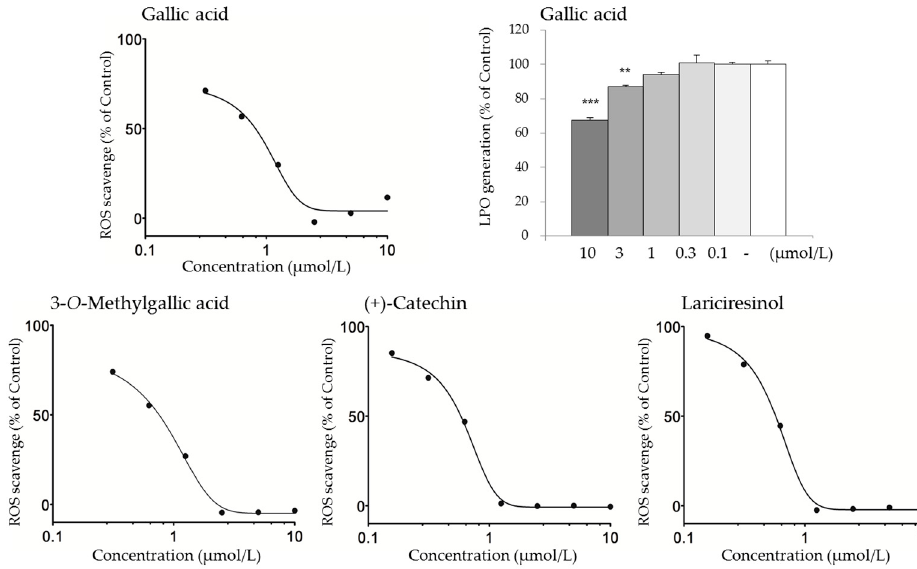
Figure 4. Concentration-dependency of antioxidant KBGY constituents. The active constituents hit in the assays of Tables 3 and 4 were assayed at the indicated serially-diluted concentrations to assess their repeatability and concentration-dependencies. Data are shown as relative amounts that are percentages of the vehicle control, representing the mean ± S.E. of triplicates ( n = 3). ** p < 0.01, *** p < 0.001, significant, respectively, versus vehicle control by Dunnett’s multiple comParison. Statistical analysis revealed that all test samples evaluated in ROS scavenging assays showed significant activities at all concentrations, although star marks indicating significant differences are not represented in the figures.